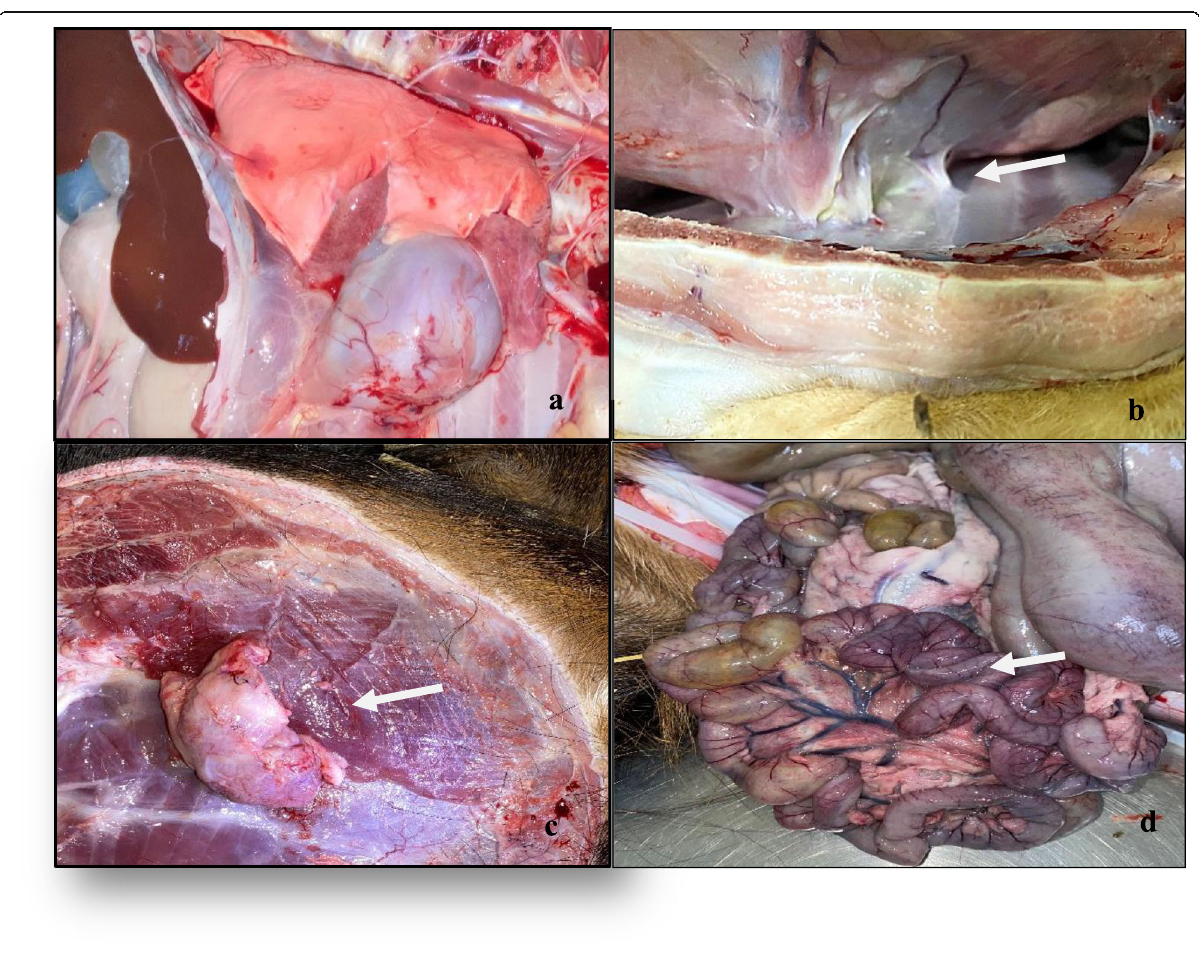
Fig. 4 Lesions following experimental infection of goats and sheep with Mycoplasma capricolum susbp capricolum isolate. a Lung consolidation. b Pleural adhesion and pleural fibrin deposits (white arrows). c Lymphadenitis of the prescapular lymph node (white arrows). d Congestion of the small intestine and blood vessels (white